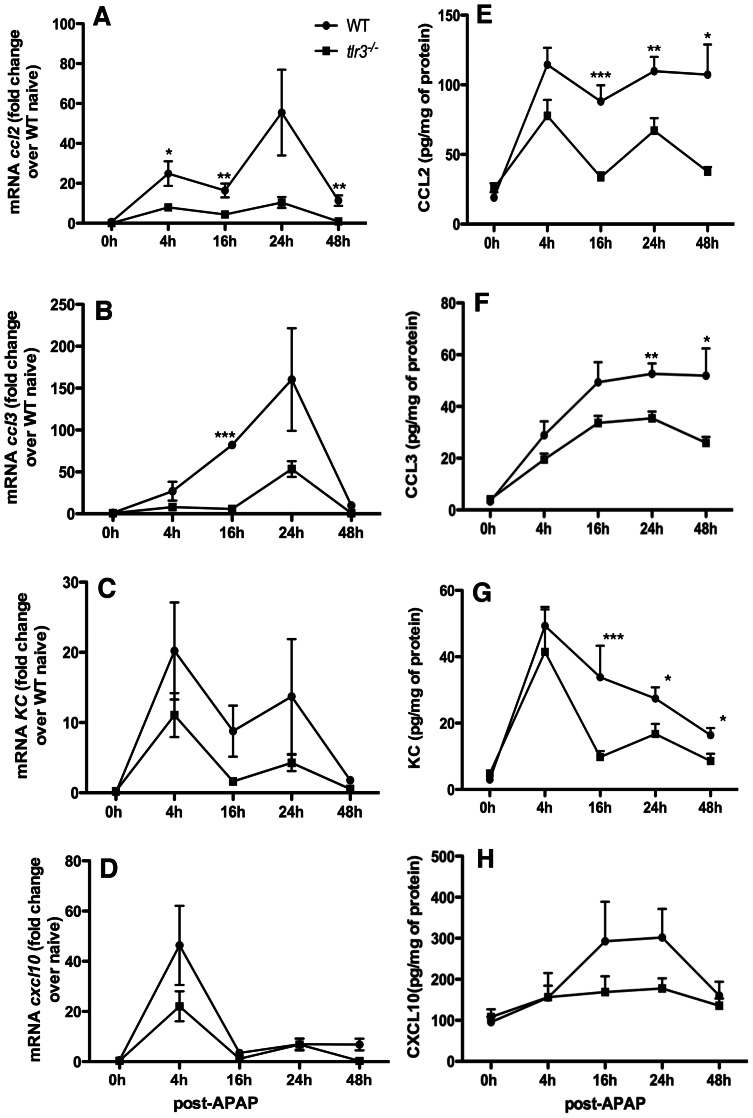
TLR3 activation increased chemokine levels following APAP-induced hepatotoxicity.Chemokine transcript levels (A–D) and protein levels (E–H) in WT and tlr3
−/− livers homogenates after APAP. The data represent mean±SEM obtained from 2–3 independent experiments (n = 5/group). *p<0.05; **p<0.01 and ***p<0.001 when WT were compared with tlr3
−/− mice.